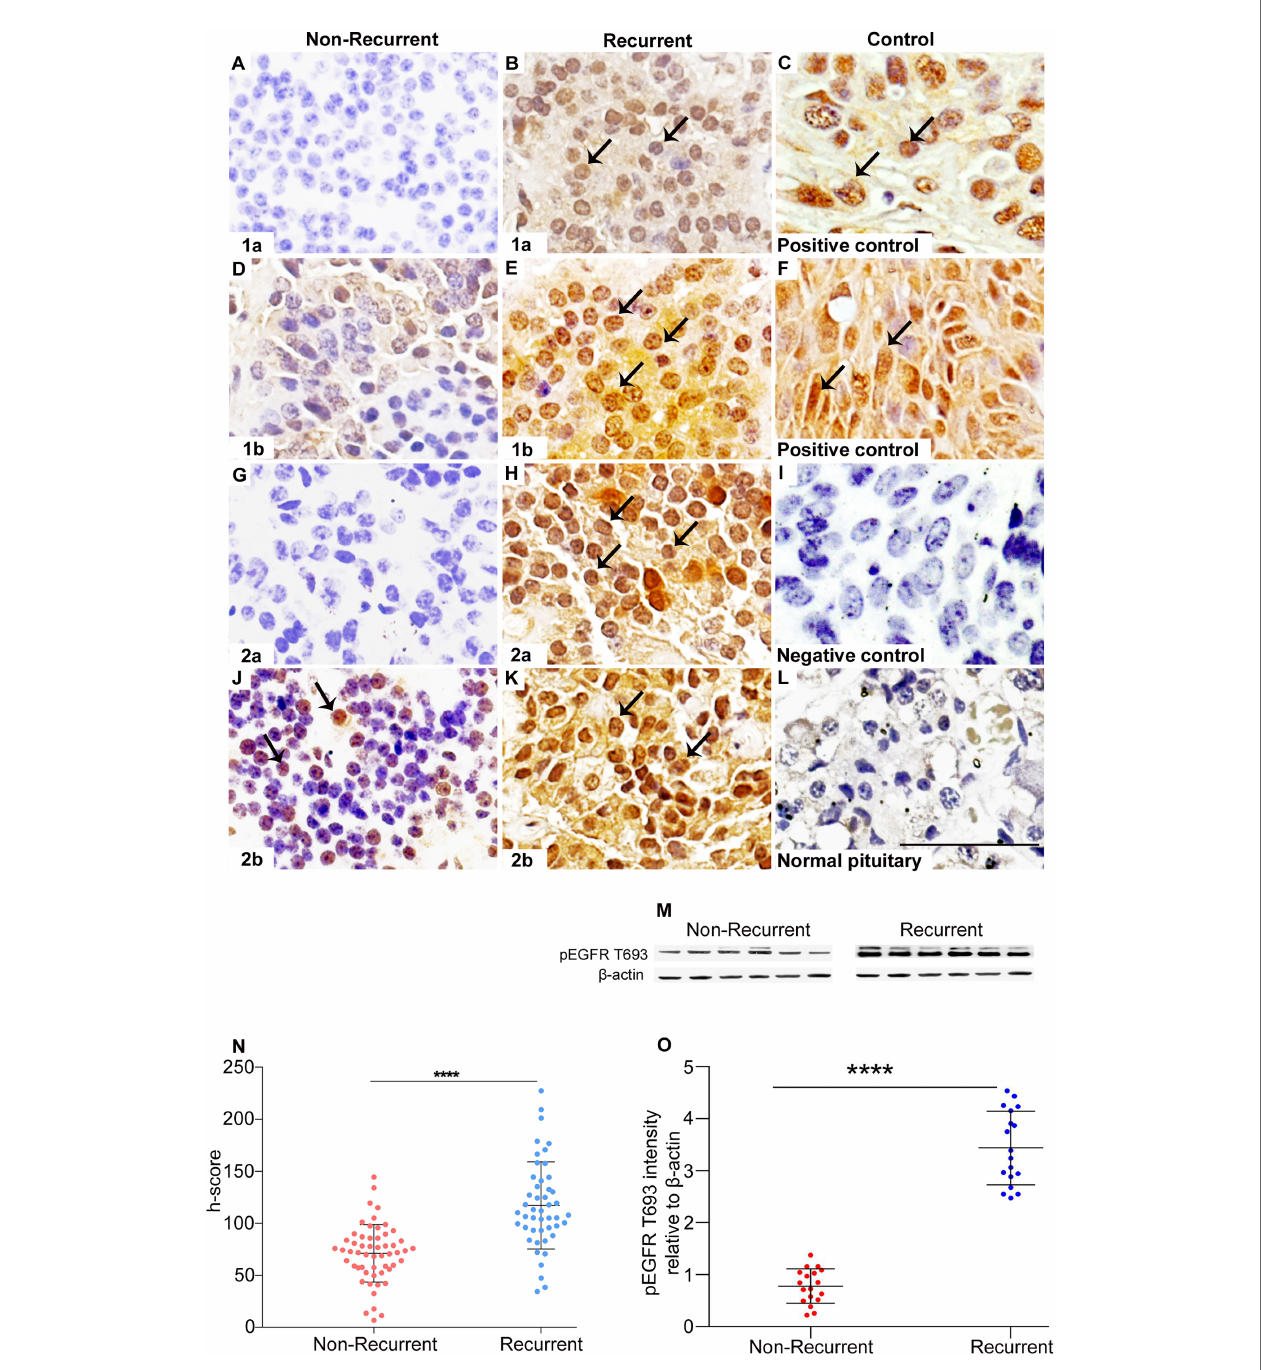
FIGURE 1 | Overexpression of pEGFR T693 in recurrent NFPAs. Immunohistochemistry of pEGFR T693 showed overexpression in recurrent NFPAs (B, E, H, K) as compared to non-recurrent NFPAs (A, D, G, J) . pEGFR T693 showed strong nuclear positivity (brown) marked by black arrows. Breast cancer (C) and cervical cancer (F) were used as the positive controls. No staining was observed in the negative control (I) and normal pituitary (L) . Western blots of representative tumor samples are depicted in (M) . The h-score (product of the number of cells with positive staining and staining intensity) showed statistically signi fi cant overexpression of pEGFR T693 in recurrent NFPAs as compared to non-recurrent (p < 0.0001) (N) . Quanti fi cation of the blots (O) show overexpression of pEGFR T693 in representative tumor samples of 18 recurrent NFPAs as compared to 18 non-recurrent ones. Magni fi cation 400x. ****highly signi fi